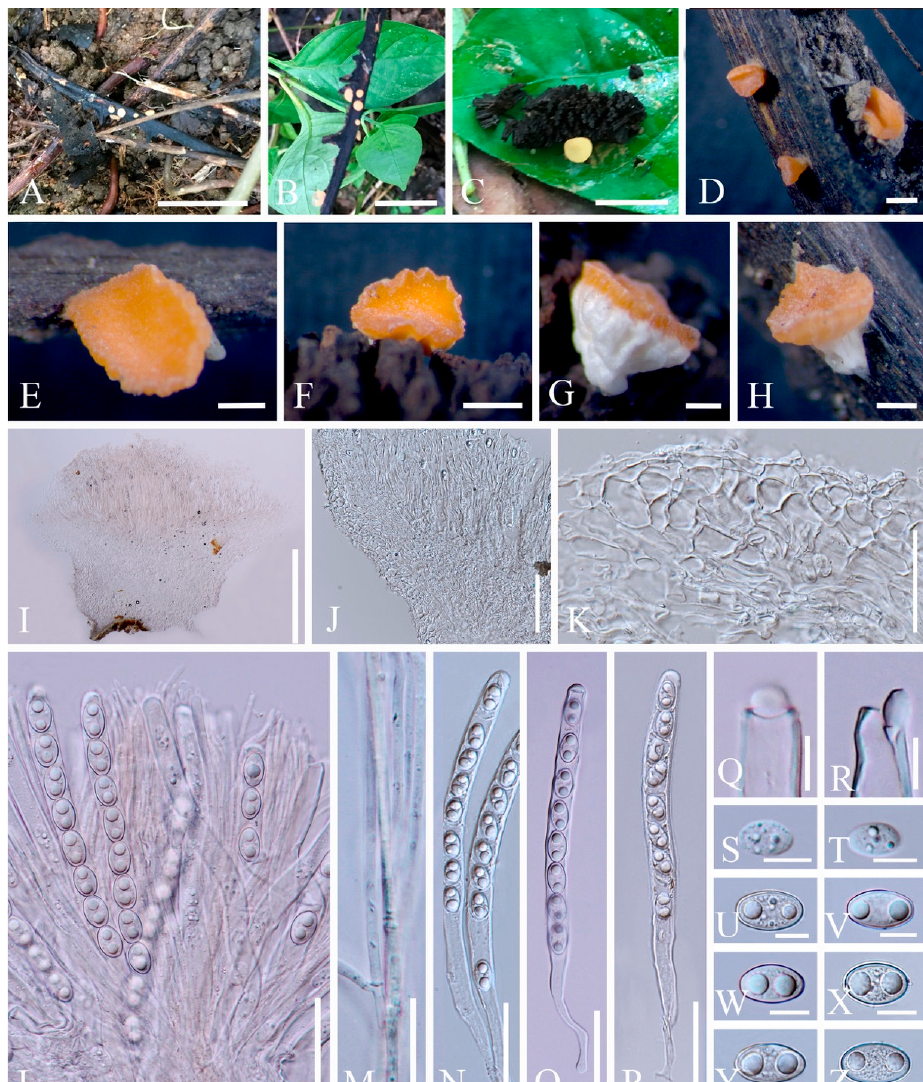
Figure 13. Nanoscypha aequispora (MFLU 21-0170, holotype). ( A – H ) Apothecia. ( I ) Vertical median section of apothecia. ( J ) Vertical median section of flank. ( K ) Vertical section of receptacle ectal excipulum. ( L ) Hymenium. ( M ) Paraphyses. ( N – P ) Asci and ascospores. ( Q – R ) Asci apices. ( S , T ) Immature ascospores. ( U – Z ) Ascospores when mature. Scale bars ( A ) = 2 cm; ( B ) = 1 cm; ( C ) = 5 mm; ( D , F ) = 1000 μ m; ( E , G – I ) = 500 μ m; ( J ) = 100 μ m; ( K , L , N – P ) = 50 μ m; ( M ) =20 μ m; ( Q – Z ) =10 μ m.